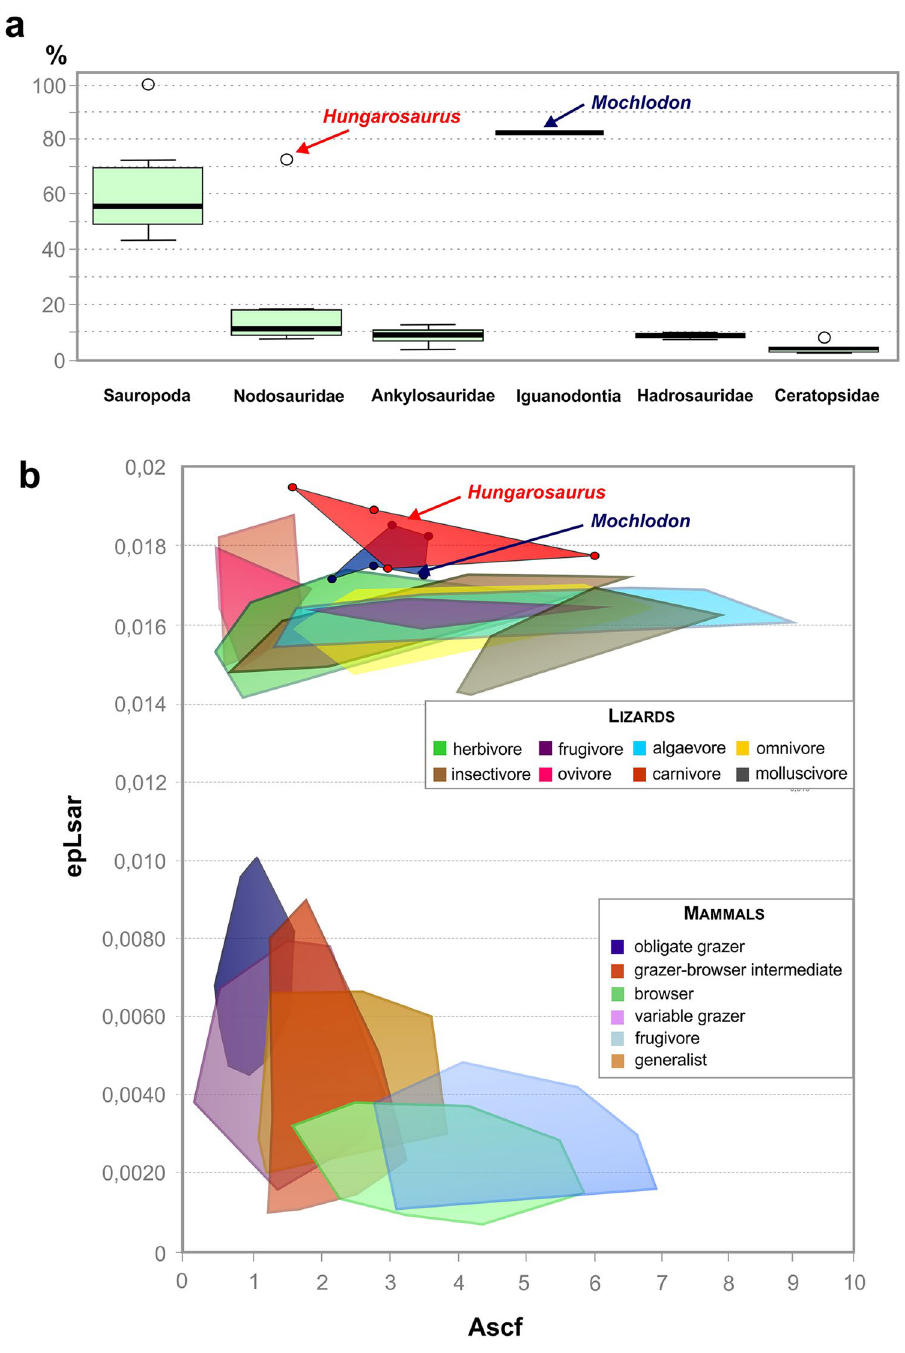
Figure 7. Microwear data comparisons. ( a ) Pit percentage (%) of Hungarosaurus tormai and Mochlodon vorosi compared to other dinosaur groups (data for other dinosaurs from 30 ). Note the extremely high pit count ratios in the Hungarian taxa, which might result from a different data collection method (see “Methods”). ( b ) DMTA data for Hungarosaurus tormai and Mochlodon vorosi compared to those taken from extant lepidosaurs (data from 87 ) and herbivorous bovid mammals (data from 52